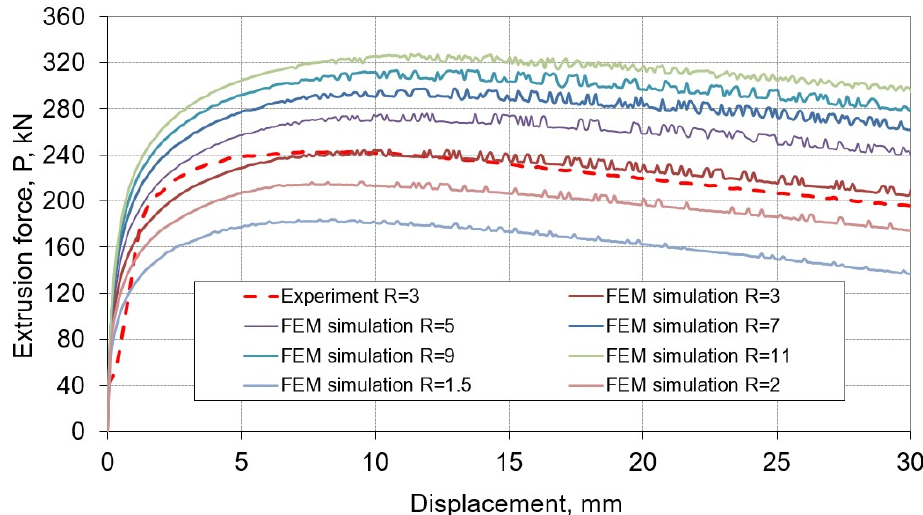
Figure 4. Experimental and numerical characteristics of the extrusion force—the displacement of the punch in the range of the tested values of the extrusion ratio R.